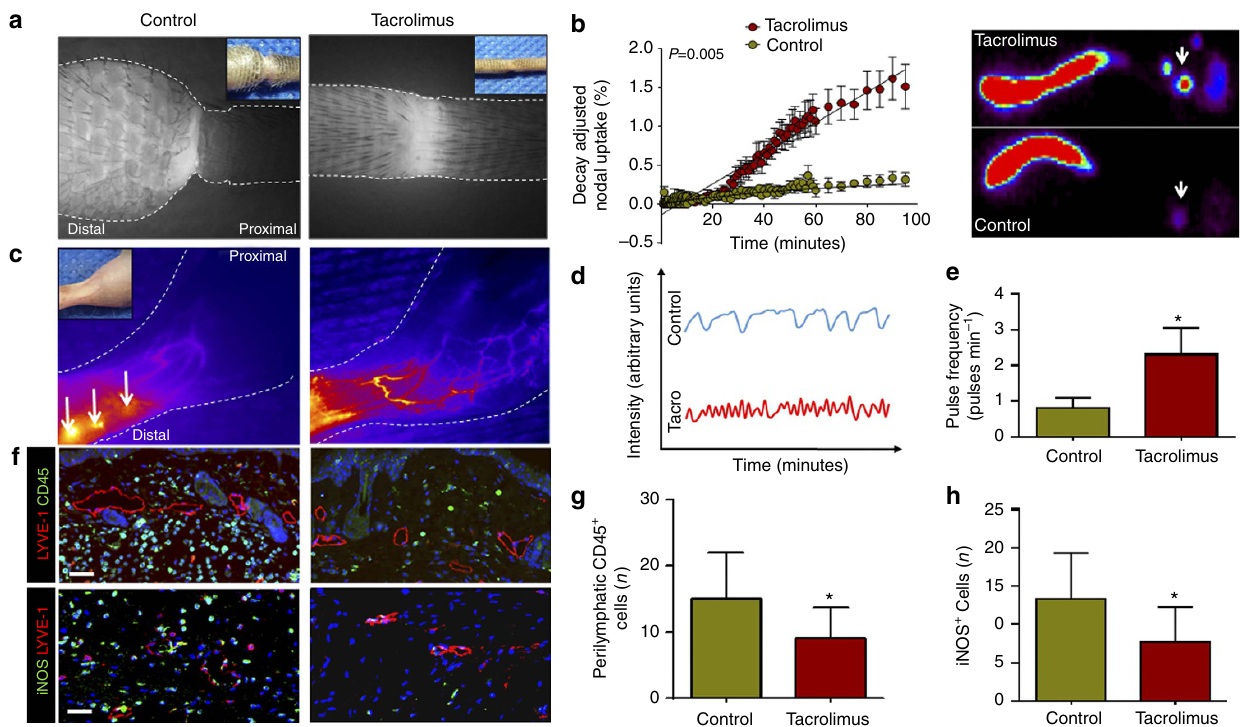
Figure 4 | Tacrolimus improves lymphatic function after surgical lymphatic injury. ( a ) Representative ICG images of mouse tails are shown 6 weeks after surgery following early treatment with or without tacrolimus. Note the flow of ICG proximally across the wound in tacrolimus-treated animals ( n ¼ 6/group). Inset shows photograph of same mice for orientation. ( b ) Decay-adjusted uptake of 99m Tc by sacral lymph nodes 6 weeks after surgical ligation of superficial/deep lymphatics in control and early tacrolimus (beginning 2 weeks after surgery)-treated animals (left panel; * P ¼ 0.005; n ¼ 6/group). Representative heat maps are shown in the right panel with the white arrow pointing towards the sacral lymph nodes ( n ¼ 6/group). ( c ) Representative ICG images of hindlimbs obtained 50min after distal foot injection in mice treated with or without tacrolimus 4 weeks after PLND ( n ¼ 6/group). White arrows show dermal backflow (increased red colour) of ICG. Inset photograph is for orientation. ( d , e ) Graphical representation of lymphatic vessel pulsations in hindlimb collecting vessels of mice treated with or without tacrolimus 4 weeks after PLND. Quantification of pulsation frequency is shown to the right (* P ¼ 0.001; n ¼ 6/group). ( f ) Representative (cid:3) 40 fluorescent co-localization images of inflammatory cells (CD45 þ , green; upper panel), iNOS þ cells (green; lower panel) and lymphatic vessels (LYVE-1 þ , red) in tissues harvested from the distal hindlimbs of animals treated with control or tacrolimus 4 weeks after PLND. Note perilymphatic accumulation of CD45 þ and iNOS þ cells. ( g ) Quantification of perilymphatic CD45 þ ( h ) and iNOS þ cells in 0.25mm 2 area (four random areas per mouse) of distal hindlimb tissues of control or tacrolimus-treated animals harvested 4 weeks after PLND (* P ¼ 0.0001 ( g ) and * P ¼ 0.0007 ( h ); n ¼ 6). Experiments were repeated two to three times. All data